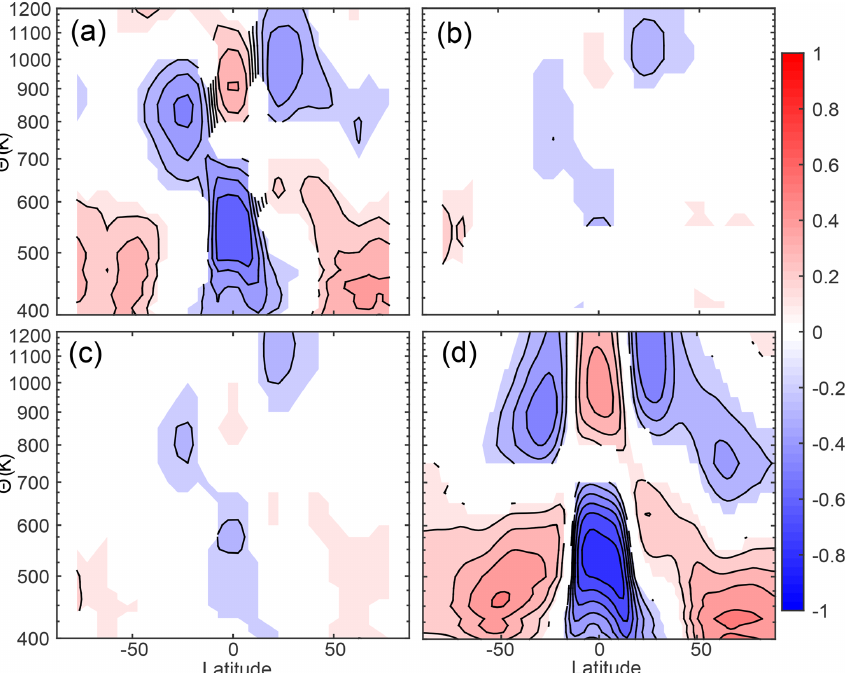
Figure 9. Correlation coefficient ( r ) of the interannual variability of total column ozone at every latitude with the total diabatic overturning circulation at every level for (a) ERA-Interim M and SBUV total column ozone, (b) JRA55 M and SBUV total column ozone, (c) MERRA M and SBUV total column ozone, and (d) ozone and M from